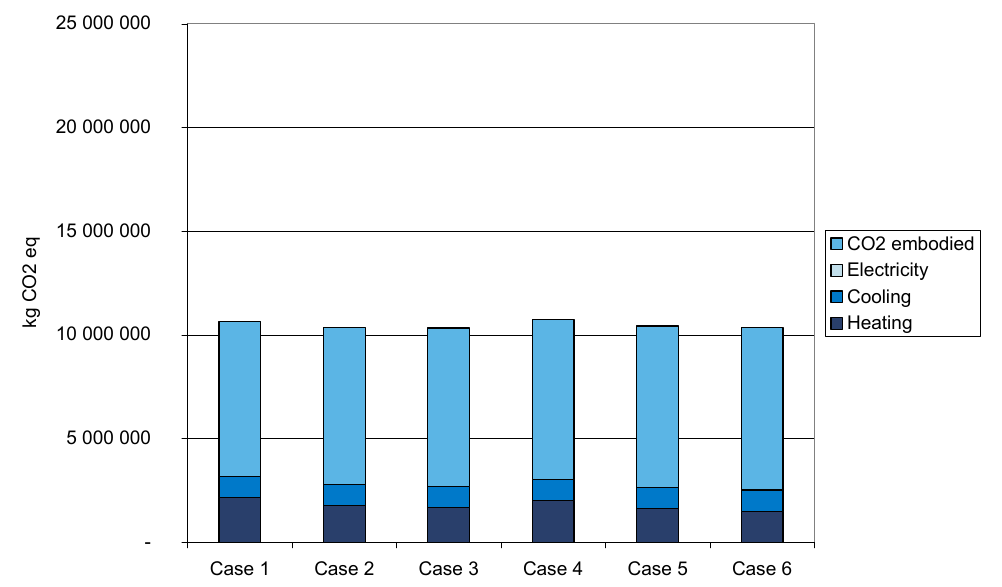
equivalent in different 2